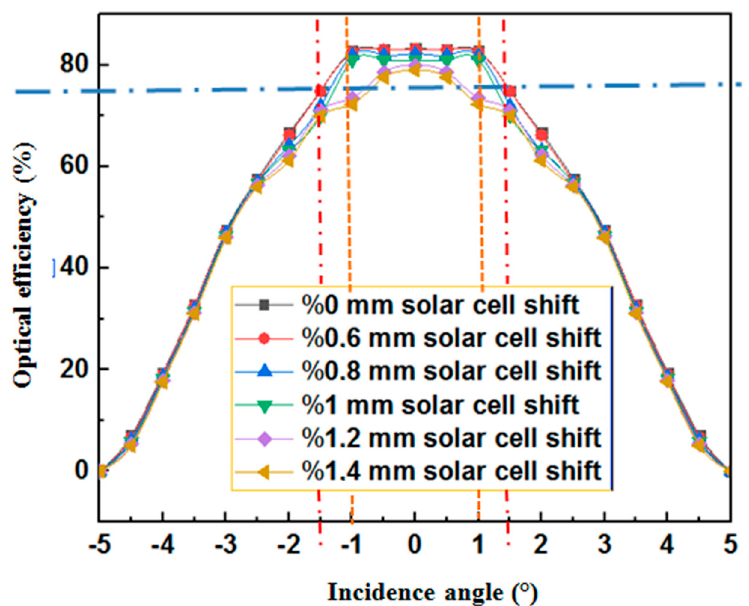
Figure 6. Solar cell shift vs. incidence angle.